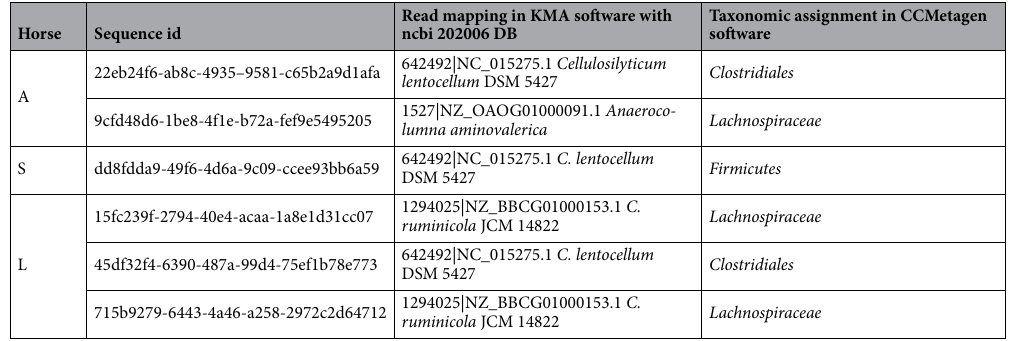
Table 2. Detailed information of sequence reads with unlinked rRNA genes.